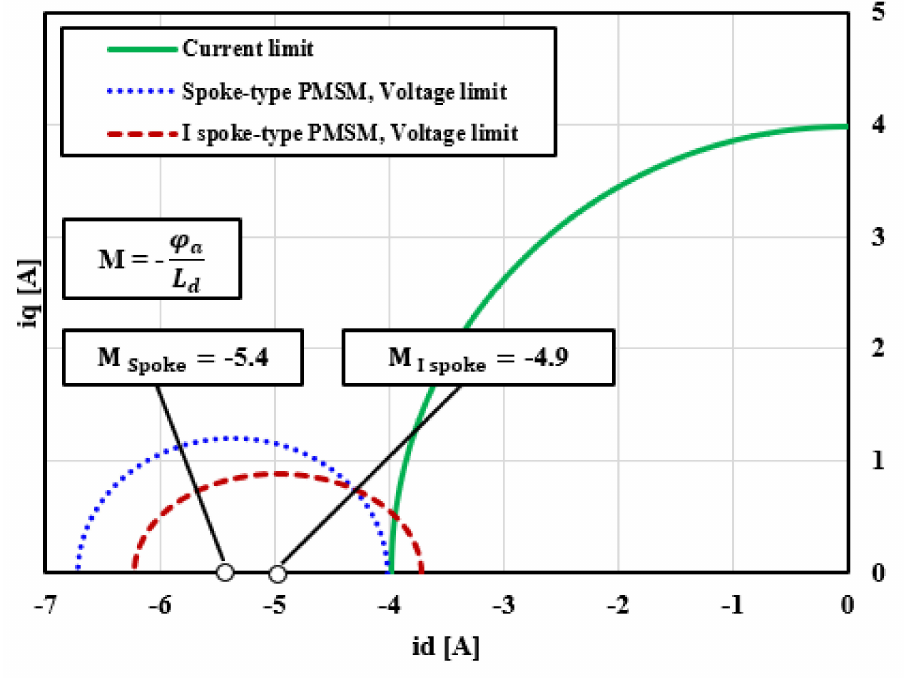
Figure 8. Comparison of operating range at 18,000